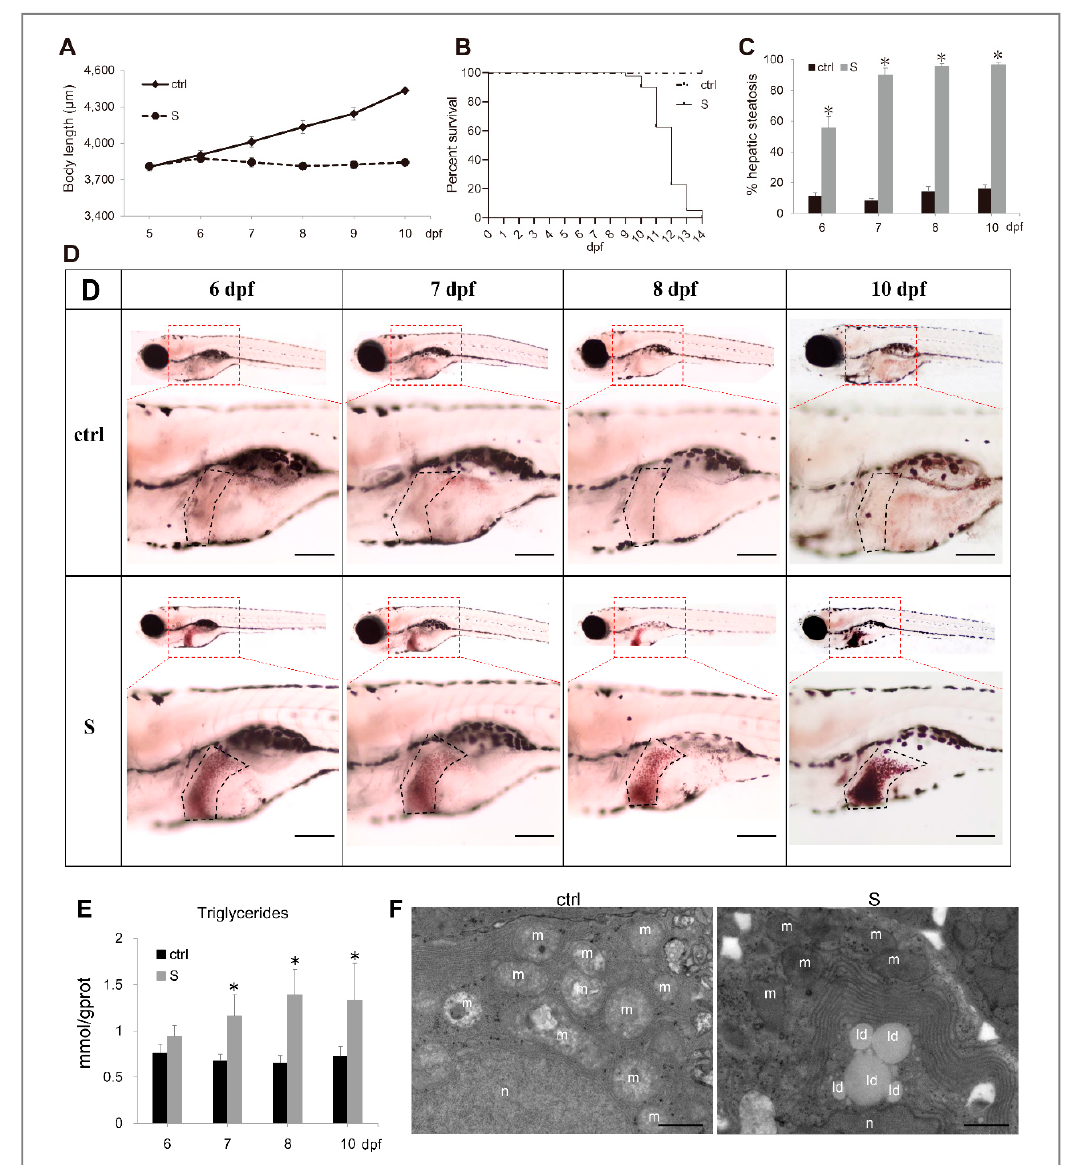
Figure 1. Characterization of starvation-induced hepatic steatosis in zebrafish larvae. ( A ) The depiction of growth perfor- mance in the control and starved larvae from 5 to 10 dpf. ( B ) The survival curve of the control and starved larvae was depicted by Kaplan-Meier assay. ( C ) Percentages of control and starved larvae with hepatic steatosis at 6, 7, 8, and 10 dpf. ( D ) Representative images of whole-mount Oil Red O (ORO) staining labelled the neutral lipids in larval liver at 6, 7, 8, and 10 dpf. White and black arrows label the liver tissues of control and starved larvae, respectively. The black dotted box labels the liver of zebrafish larvae. Bars = 200 μ m. ( E ) Hepatic triacylglycerol (TAG) levels in the control and starved larvae from 6 to 10 dpf were determined. ( F ) Electron micrographs of hepatocytes from the control and starved larvae. Id: lipid droplets; m: mitochondria; n: cell nucleus. Bars = 10 μ m. * indicates significant differences ( p < 0.05).